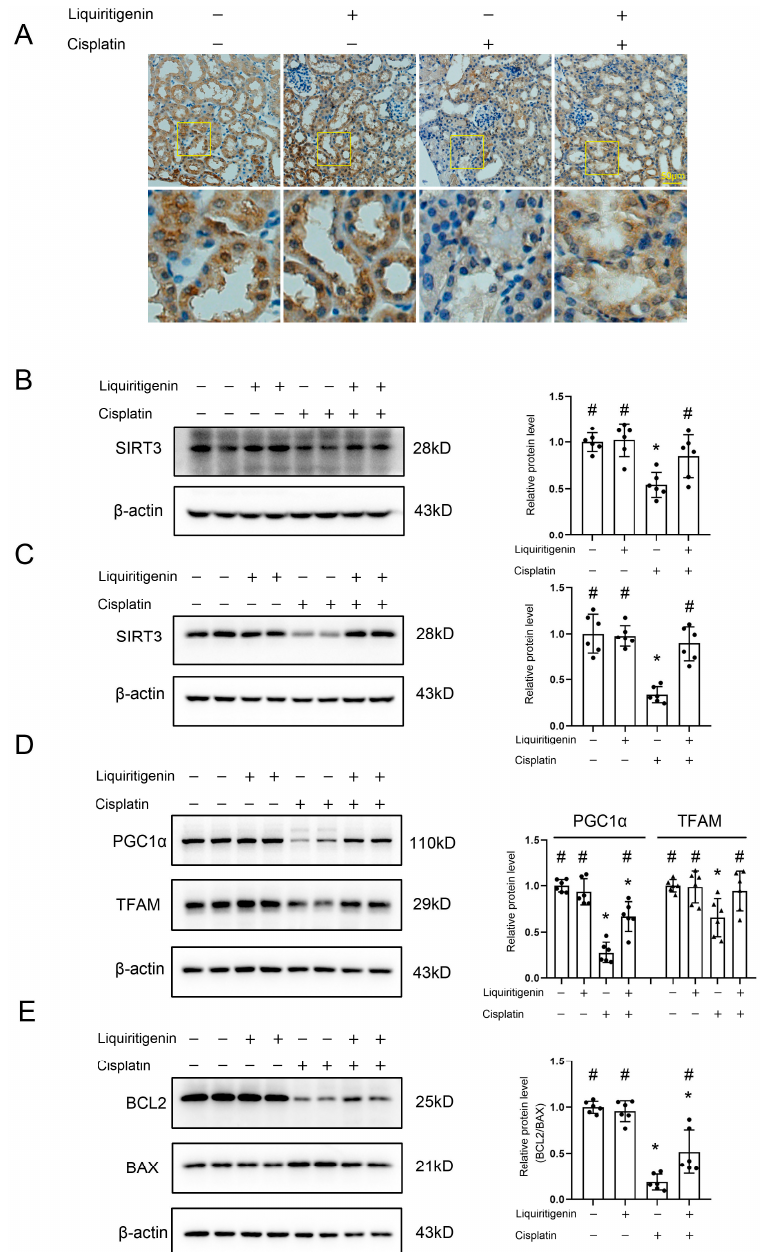
Figure 6. The effect of liquiritigenin on the protein levels through NRF2-SIRT3 signaling. ( A ) Repre- sentative photomicrographs of SIRT3 immunohistochemical staining in the kidneys from different groups of mice. ( B ) Representative Western blot gel documents and summarizes the data showing the levels of SIRT3 in the kidney from different groups of mice ( n = 6 mice/group). * p < 0.05 vs. control group of mice, # p < 0.05 vs. mice with CP treatment. ( C ) Representative Western blot gel documents and summarized data show the levels of SIRT3 in live cultured renal tubule epithelial cells with different treatments. * p < 0.05 vs. control group, # p < 0.05 vs. CP treatment group. Data